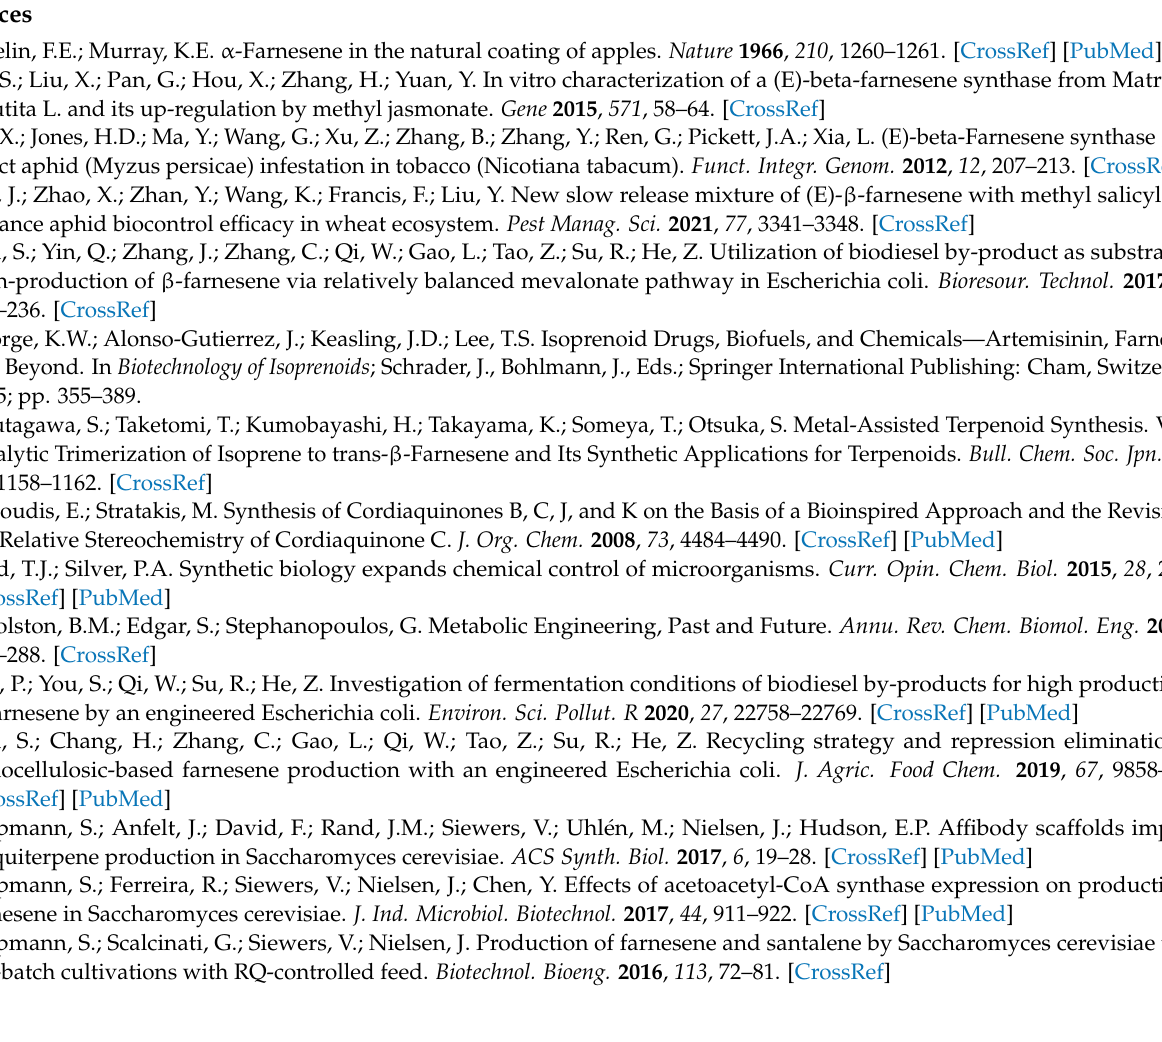
Table S2: Primers used in this work; Table S3: The exogenous DNA used in this study; Figure S1: Schematic representation of gene chromosome integration in this study and schematic representation of pRSF vector